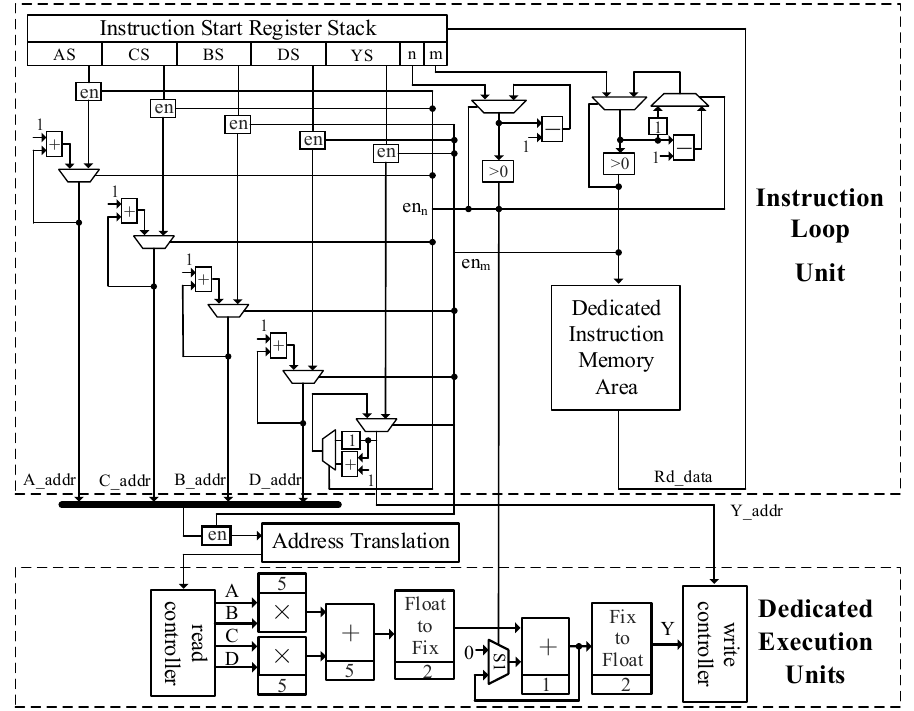
Figure 11. Structure of dedicated execution units and instruction loop unit.